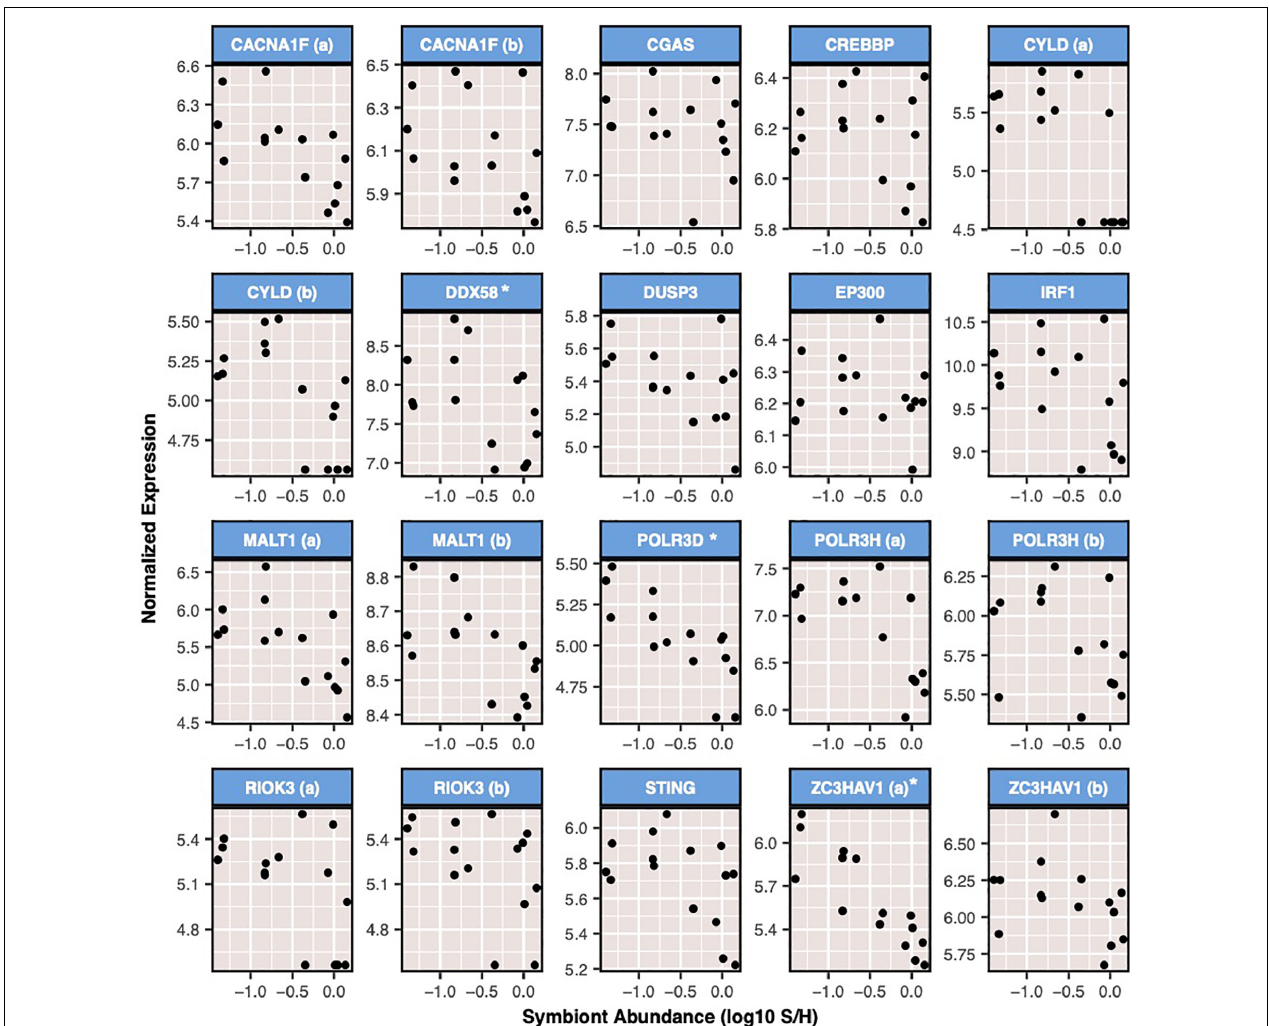
FIGURE 5 | Expression of transcripts from module 8 that were included in significantly enriched BP GO terms related to immune function. Expression is shown for all samples relative to sample S/H (symbiont density). Expression is displayed as variance stabilizing normalized values. * indicates transcripts which were significantly differentially expressed as a result of symbiont density ( Padj < 0.05). Genes are listed in alphabetical order by gene id. Those displayed are: voltage-dependent L-type calcium channel subunit alpha-1F (CACNA1F), cyclic GMP-AMP synthase (CGAS), CREB-binding protein (CREBBP), ubiquitin carboxyl-terminal